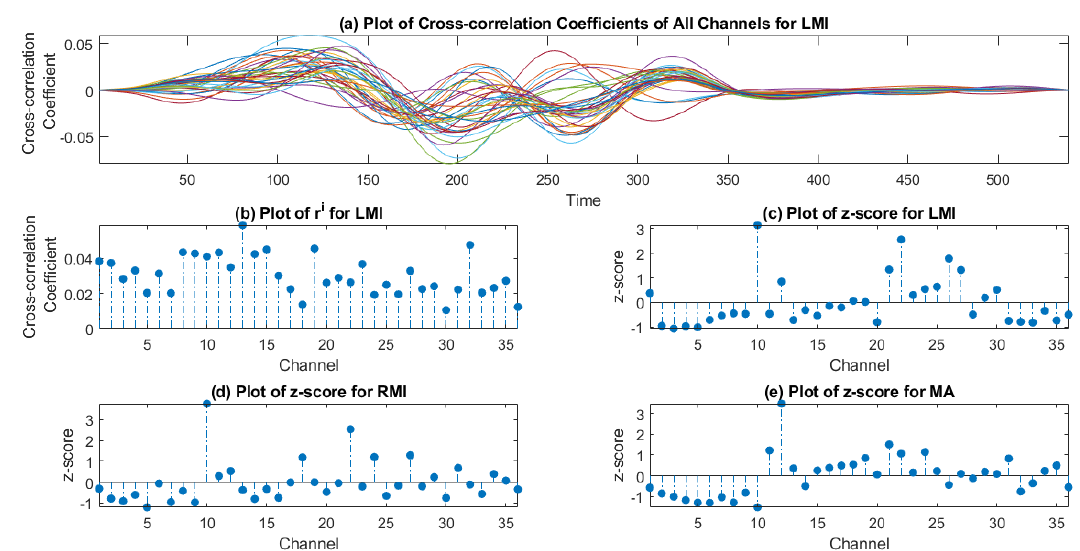
Figure 6. ( a ) Plot of cross-correlation coe ffi cients of all channels for LMI for subject 28, ( b ) plot of r i ; vector containing maximum value of all channels for LMI for subject 28 and plot of z-score for ( c ) LMI, ( d ) RMI, and ( e ) MA task of subject